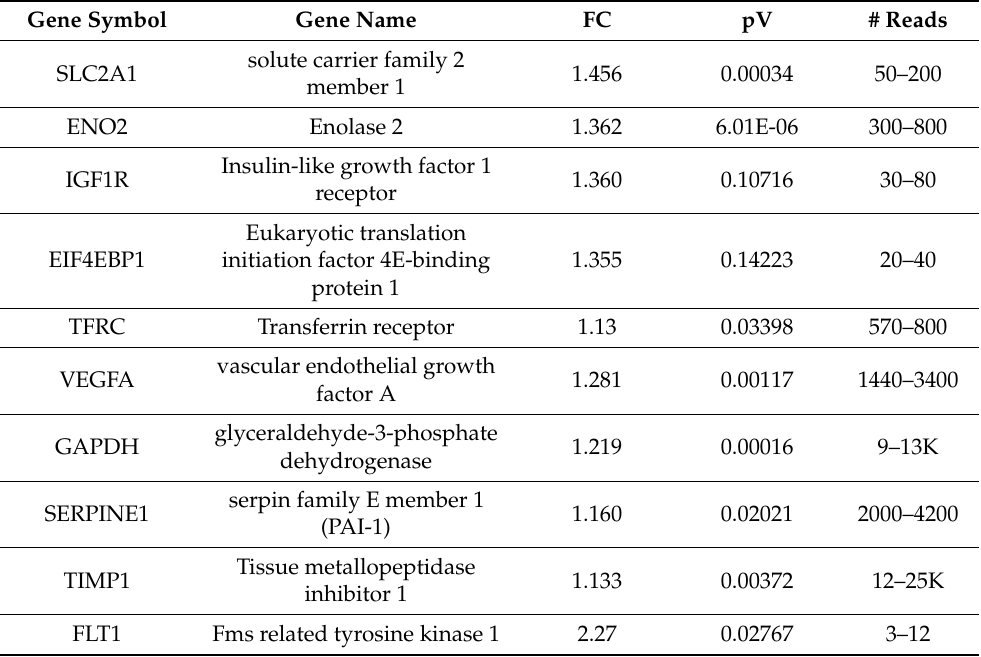
Table 1. Genes upregulated in N-HLFs following culture on IPF-CM related to HIF1 α signaling pathway